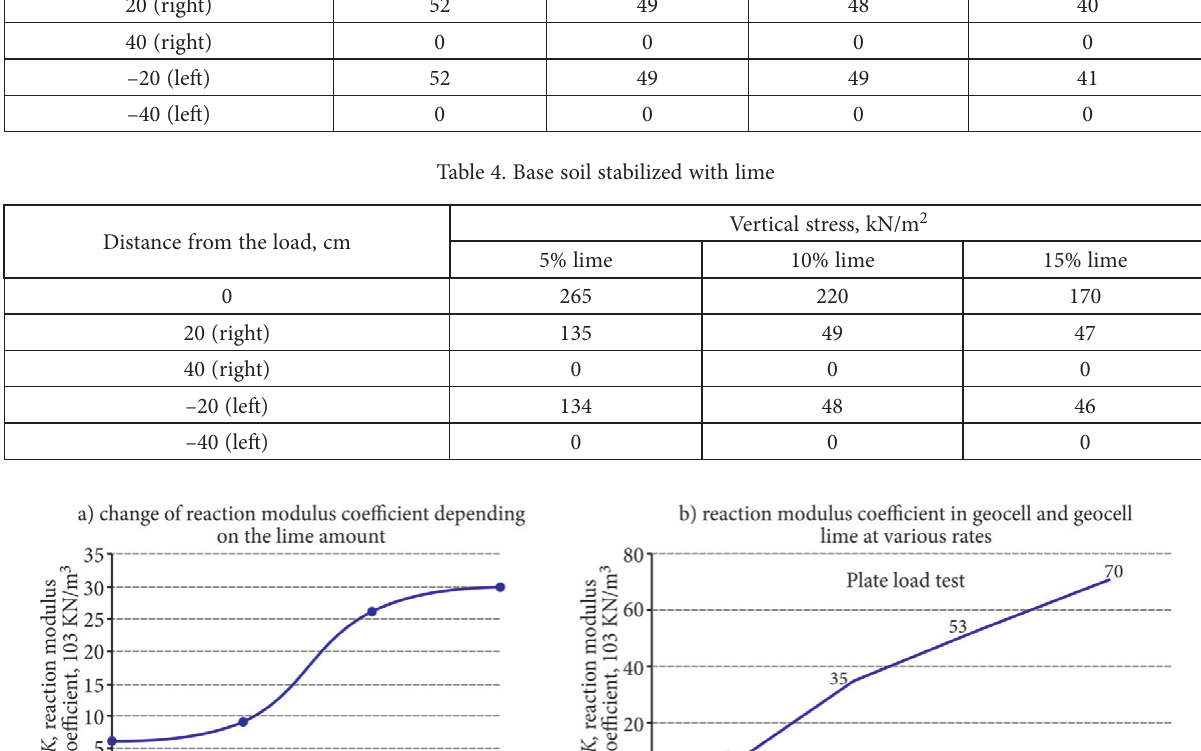
Table 3. Vertical stresses on unreinforced and geocell reinforced base Distance from the load, cm